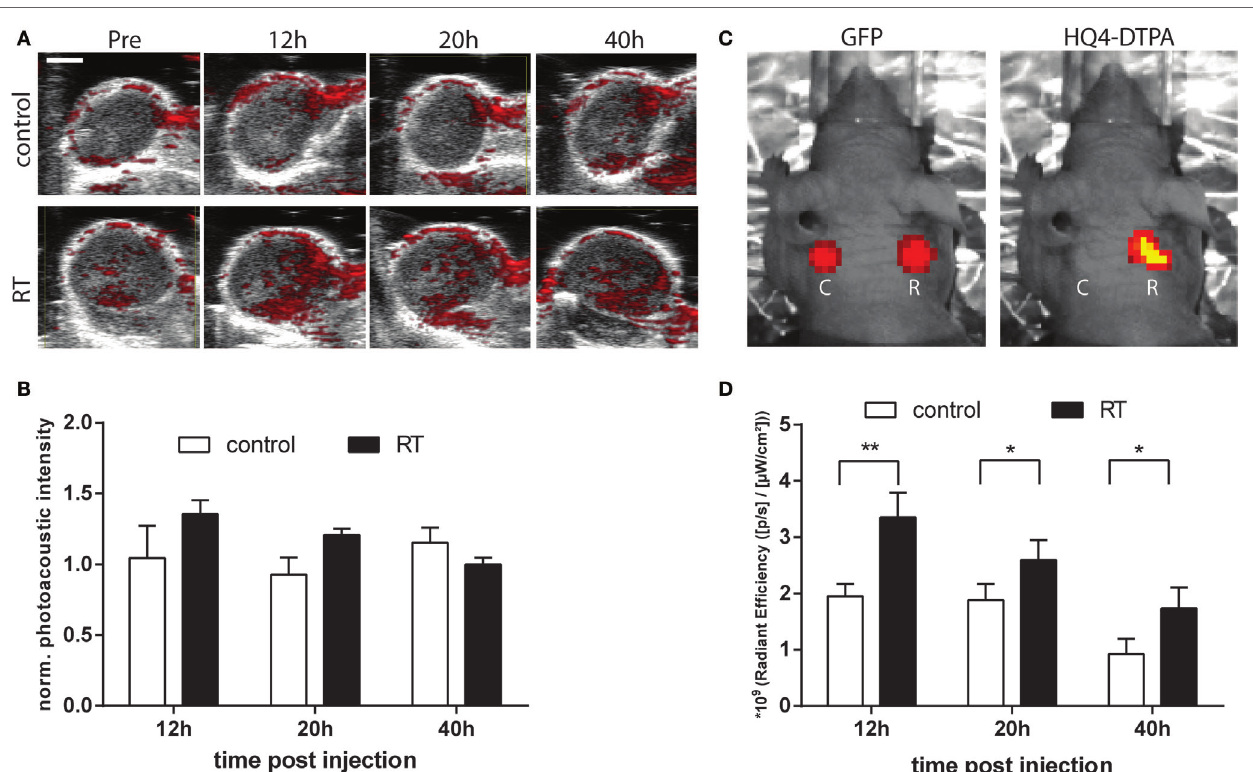
FigUre 4 | In vivo photoacoustic and fluorescence imaging of tumors . (a) Representative photoacoustic images of control and irradiated tumors prior to and at 12, 20, and 40 h following injection of HQ4-DTPA. The photoacoustic image was acquired at 700 nm and an accumulation of HQ4-DTPA inside the irradiated tumor was observed. Scale bar = 2 mm. (B) Measured photoacoustic intensity at different time points ( n = 3/group). (c) Representative fluorescence images of the GFP-MCF7 tumor and HQ4-DTPA in control (C) and irradiated (R) tumors. (D) Measured fluorescence intensity of HQ4-DTPA at different time points ( n = 10/group, * p < 0.05, ** p <